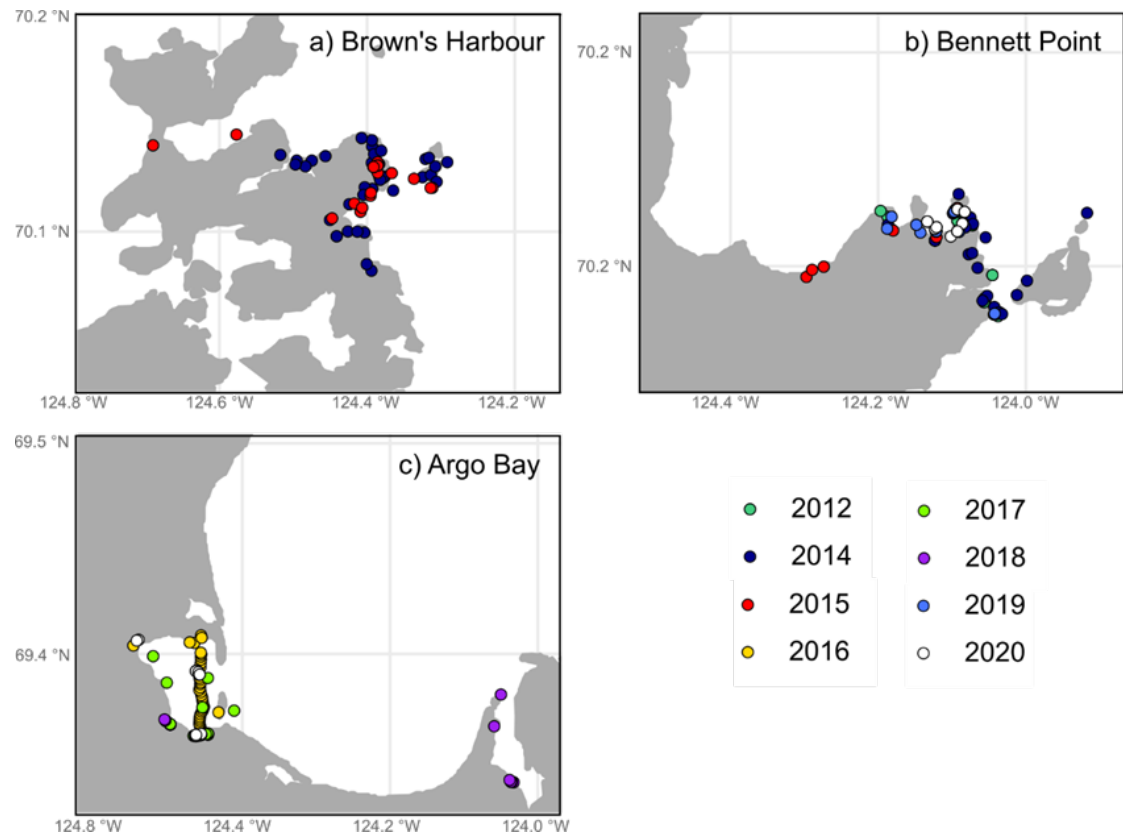
Figure 15. Stations sampled for fish community composition within the vicinity of the ANMPA during the Arctic Coast summer fish surveys from 2012 to 2020. Sampling gears included trap nets, gillnets, and seine